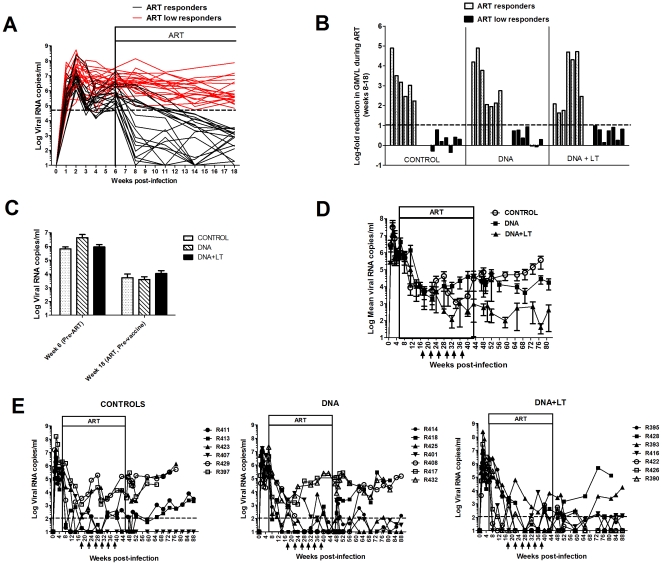
Therapeutic DNA vaccination reduces viral load and protects from viral rebound after drug is stopped.Plasma viral RNA load was determined by real time RT-PCR. Boxed areas (ART) indicate period of antiretroviral drug therapy. Arrows indicate DNA vaccine doses. (A) Response to ART (weeks 0–18). Shown are viral loads in 41 SIV-infected macaques before starting ART (weeks 0–6) and during the first 12 weeks of ART only (weeks 6–18). ART responders (black) had declining viral loads during ART only. ART low responders (red) had little or no decline in viral loads during ART only and maintained ≥5×104 viral RNA copies/ml (dotted line). (B) Log-fold reduction in viral load during ART only. The change in viral load during ART in each animal was determined by dividing the mean viral load prior to initiating ART (weeks 4–6) by the mean viral load during the first 12 weeks of ART but prior to initiating the therapeutic vaccinations (weeks 8–18). Shown is the log-fold reduction in mean viral load during ART for each animal. ART low responders had <1 log-fold reduction. ART responders exhibited 1.6–4.9 log-fold reductions in viral load during ART. (C) Mean plasma viral loads in each group prior to initiating ART (week 6, Pre-ART) and after 12 weeks on ART but before starting therapeutic vaccinations (week 18, Pre-vaccine). (D) Mean plasma viral loads during vaccinations and after withdrawing ART. Differences in mean viral loads after withdrawing ART are significant starting at weeks 68 and 48 in the DNA (P = 0.019) and DNA+LT (P = 0.002) groups, respectively, and remained significant thereafter when compared to controls (Wilcoxon test). (E) Viral loads in each animal. Protection from viral rebound was defined as containment of viral load ≤100 viral RNA copies/ml (hashed line) for a period of at least 5 months after drug was withdrawn (weeks 45–66).